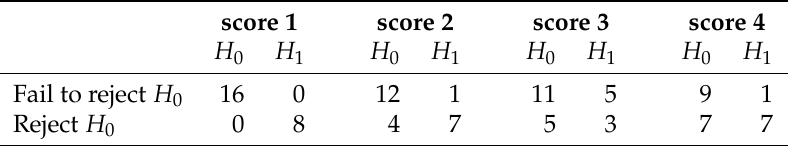
Table 6. Categorization of the samples with respect to the presence or absence of damage and the result of the test for each of the four scores when the size of the samples to diagnose is ν =